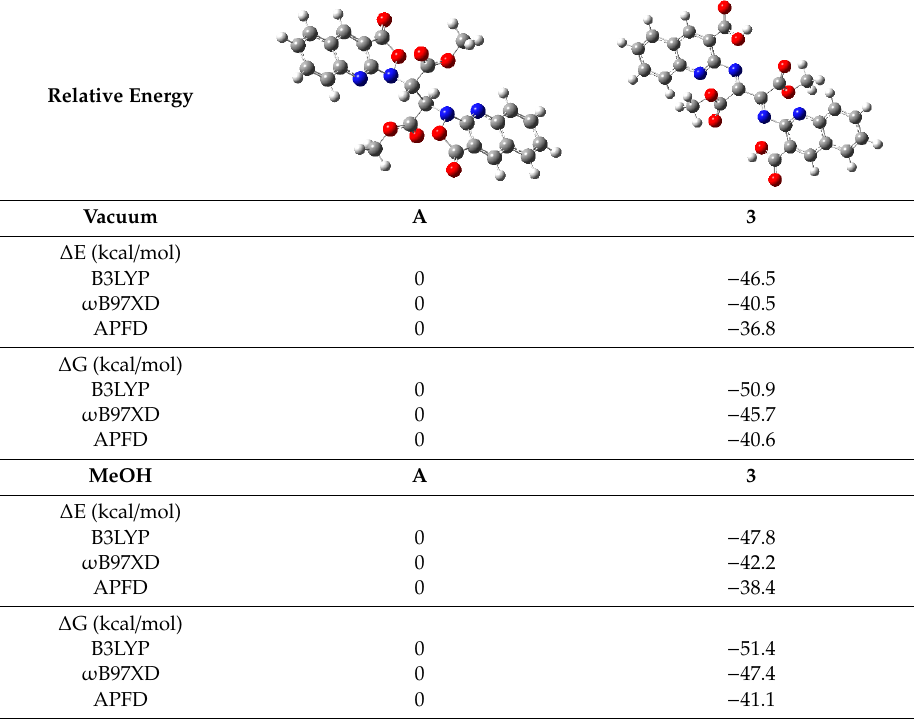
Table 1. Relative electronic energies ( Δ E), and Gibbs free energies ( Δ G) for isomers A and 3 calculated using B3LYP, ω B97XD, and APFD density functionals and 6-31G+(d) basis set in vacuum and with PCM (MeOH) solvation model.